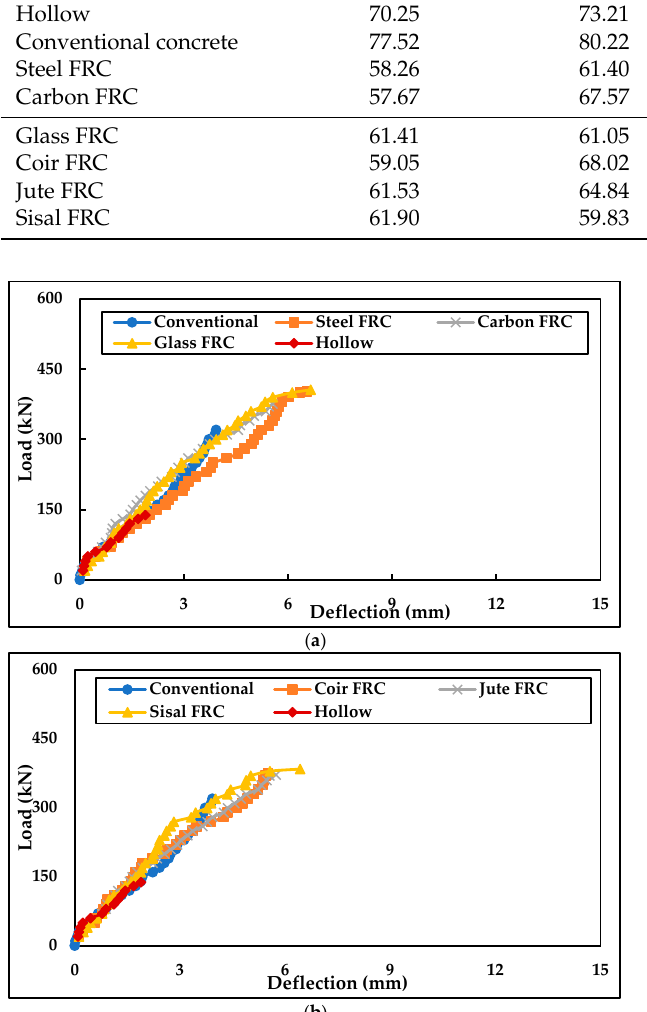
Figure 10. Graphical illustration of load vs. deflection of short column. ( a ) Artificial FRC. ( b ) Natu- ral